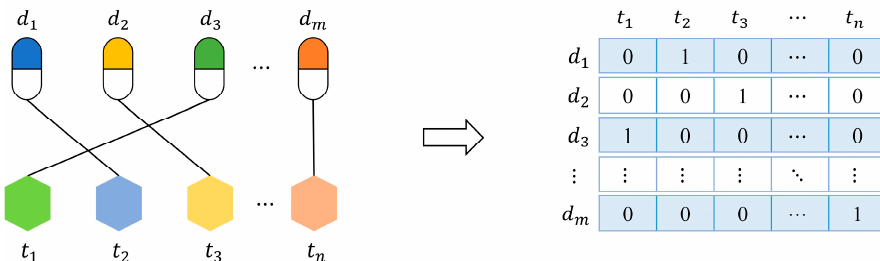
Figure 2. A drug-target interaction network and interaction profiles of drugs.